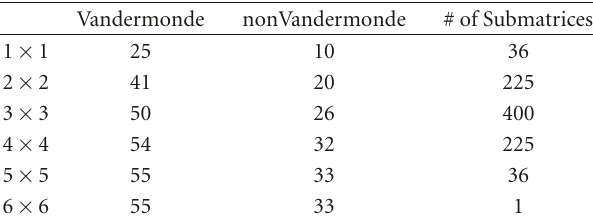
Table 1: The Maximum Degree Determinant in 6 × 6 Matrix